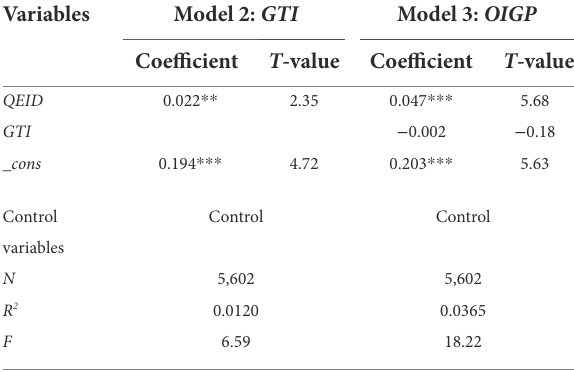
TABLE 5 Results of mediating regression ( GTI)